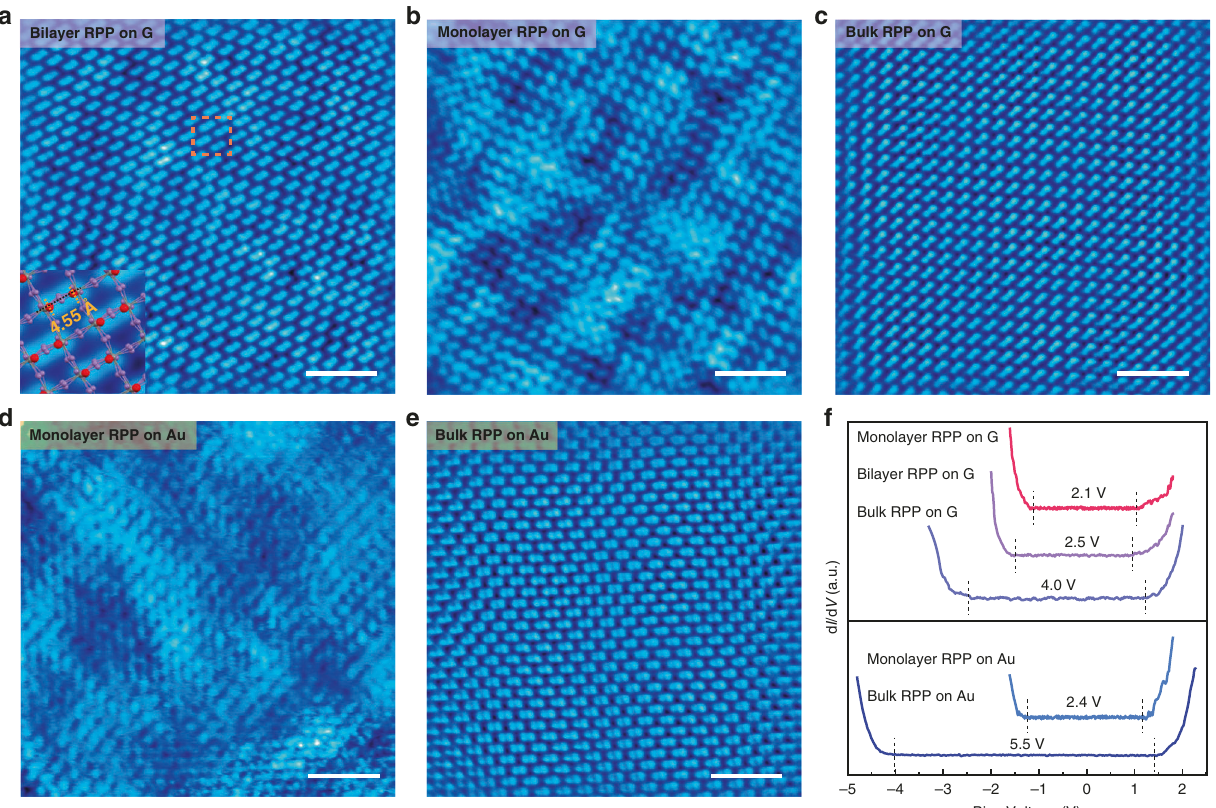
Fig. 2 Scanning tunneling microscopy (STM) and spectroscopy (STS) on exfoliated n = 4 RPP fl akes of different thicknesses on G and Au substrates. Empty State ( + 2.3 V, 10 pA) images of a bilayer RPP on G; b monolayer RPP on G; c thick RPP on G. d Monolayer RPP on Au. e Thick RPP on Au. Scale bars, 4 nm ( a – e ). f STS (d I /d V ) of n = 4 RPP fl akes of different thicknesses on G and Au